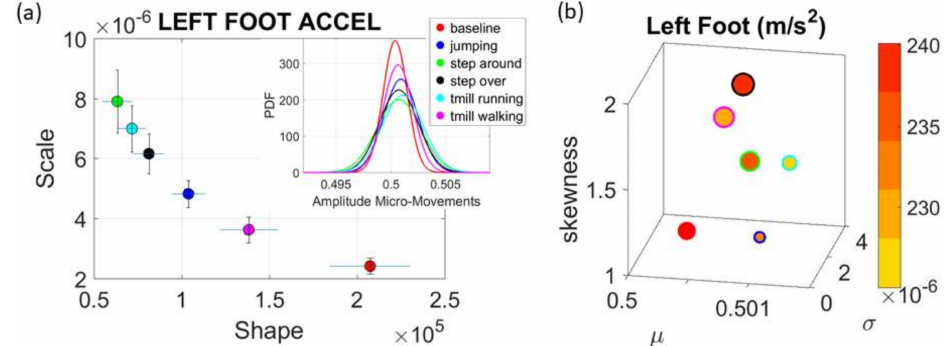
Figure 9. Comparison of different activities using Zeblok smart shoes. ( a ) Gamma parameters from left foot peak-timing spike trains by itself can distinguish walking normally (baseline) from walking on a treadmill and jumping. Other activities with more subtle requirements (walking around or over an obstacle) are also different from baseline walking. ( b ) Gamma moments further confirm these distinctions. Color gradient shows the range of deviations from the estimated mean (peak